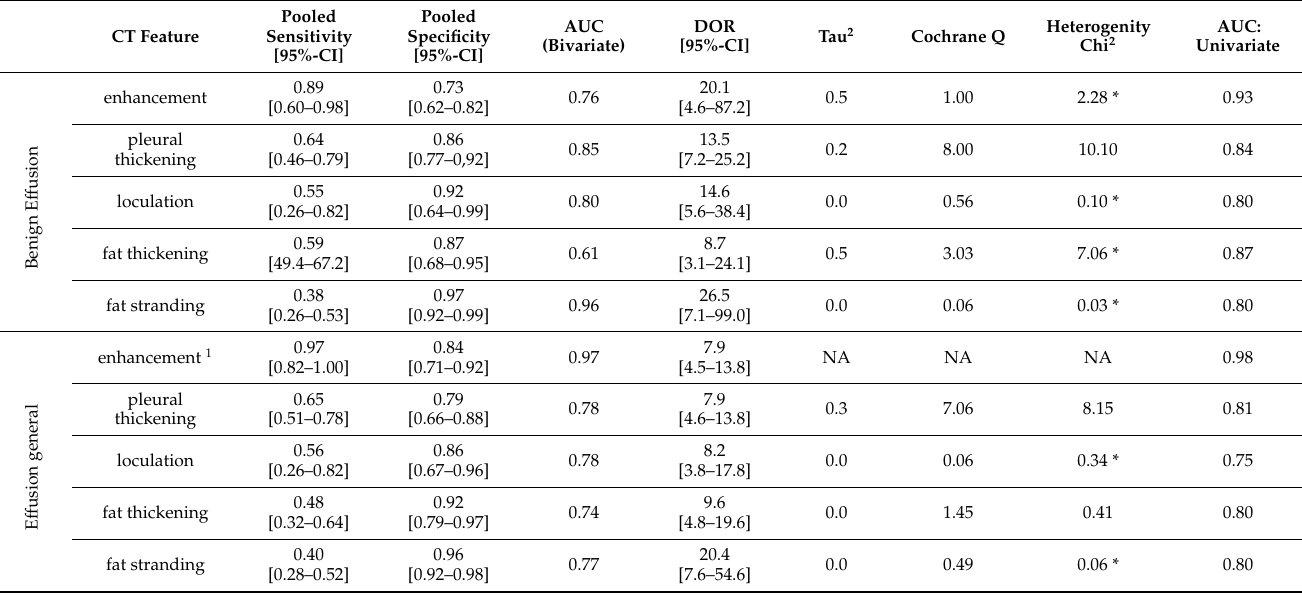
Table A5. Diagnostic accuracy measures of pleural findings in benign effusions and effusions in general.